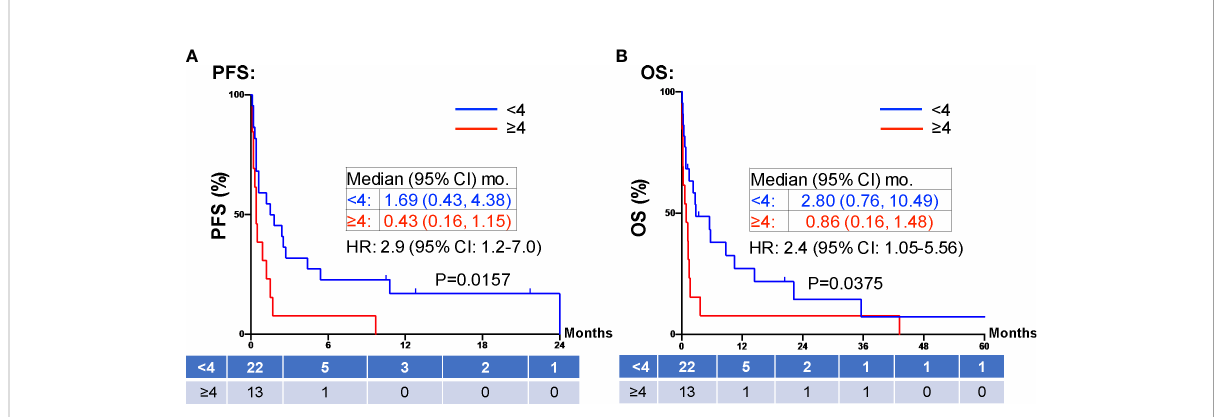
FIGURE 5 PFS and OS strati fi ed by dNLR. Patients with high dNLR ( ≥ 4, red) at prior to inpatient treatment was associated with shorter PFS (A) and OS (B) compared to those patients with low dNLR (<4, blue). Groups were compared using the log-rank test. Tick marks indicate censored data.